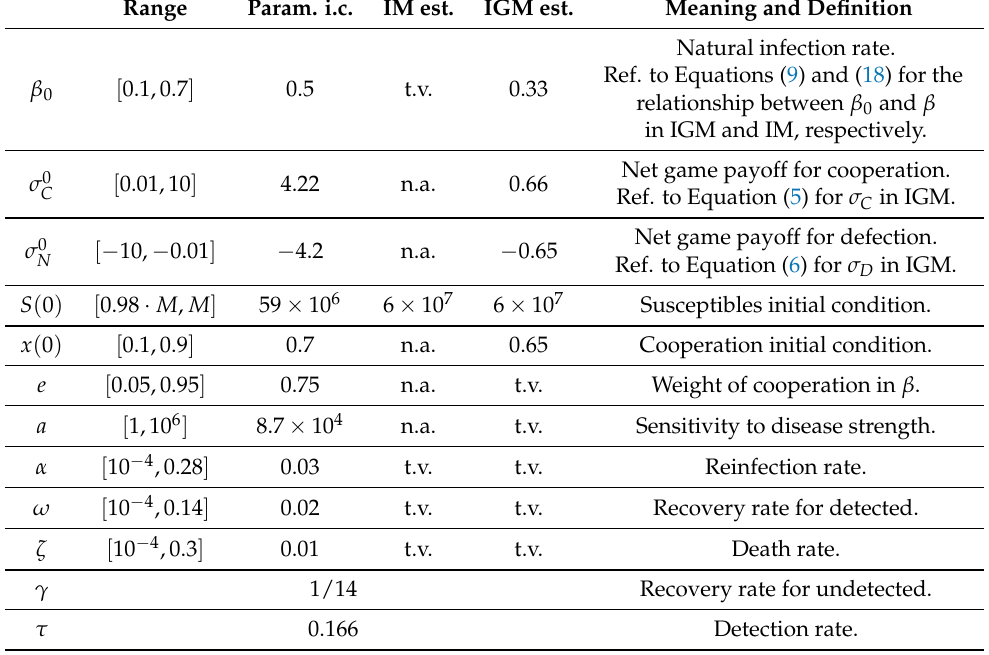
Table 1. Values of the estimated parameters in the set θ 1 and in the θ 2 , values of parameters in the set θ 3 , ranges and initial conditions used for the estimation. Moreover, t.v. stands for “time varying”, while n.a. means that the parameter is not estimated in the corresponding model. Range Param. i.c. IM est. IGM est. Meaning and Definition Natural infection rate. Ref. to Equations (9) and (18) for the β 0 [ 0.1,0.7 ] 0.5 t.v. 0.33 relationship between β 0 and β in IGM and IM, respectively. Net game payoff for cooperation. [ 0.01,10 ] 4.22 n.a. 0.66 σ 0 C Ref. to Equation (5) for σ C in IGM. Net game payoff for defection. n.a. − 0.65 Ref. to Equation (6) for σ D in IGM. Susceptibles initial condition. Cooperation initial